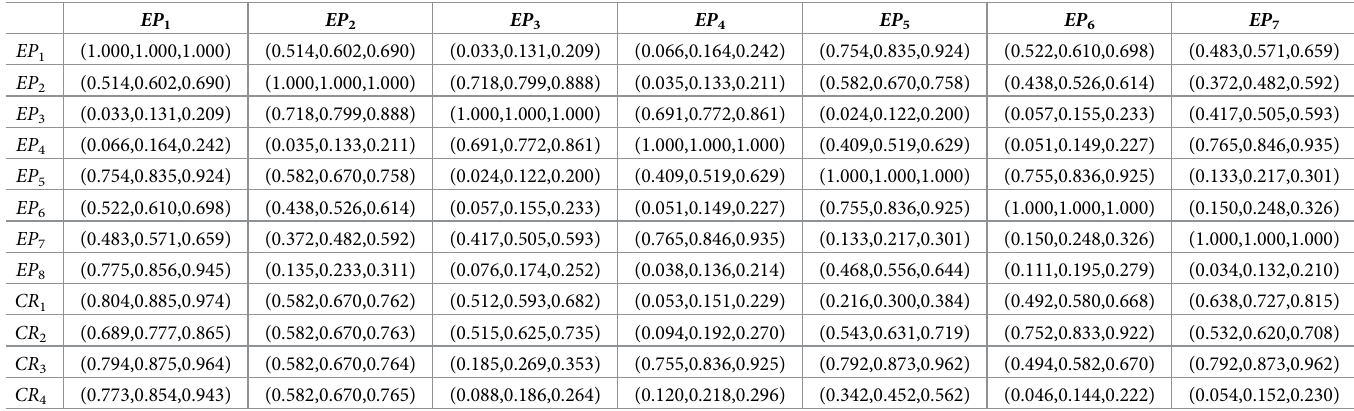
Table 10. Fuzzy value of evaluation information in the first stage